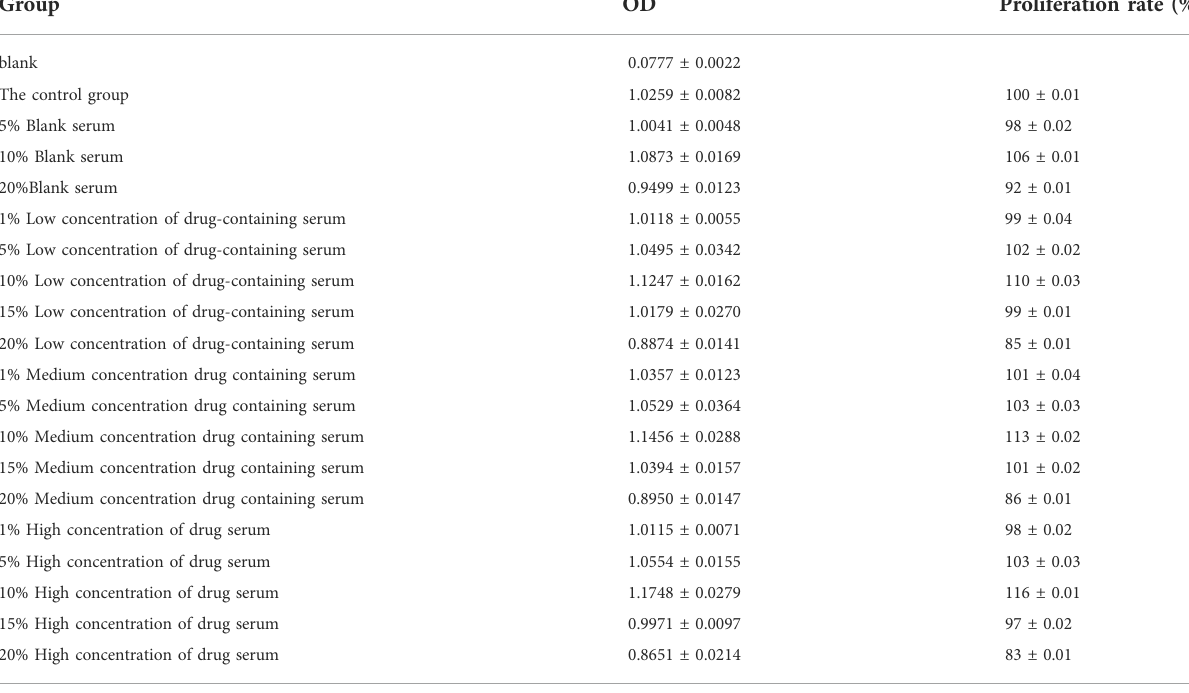
TABLE 3 The effect of different concentrations of Gubenzenggu granule medicated serum on the proliferation of MC3T3-E1 cells. Group